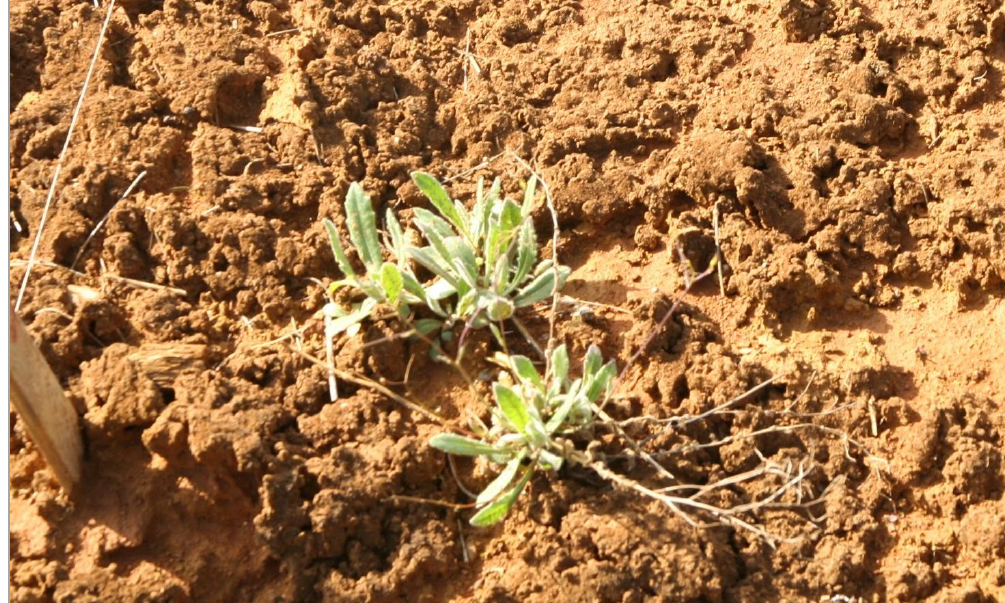
Fig. 11. Young seedlings of Biscutella laevigata in the summer of 2012 ( A. Rostański )